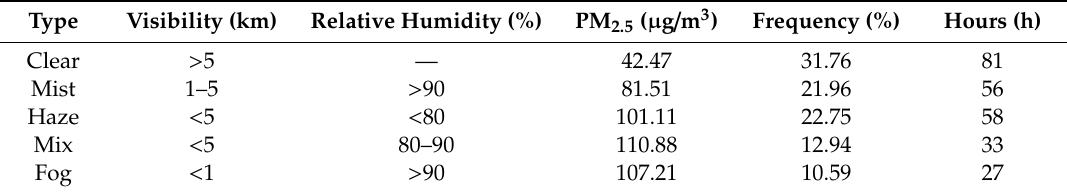
Table 1. The occurrence frequency of different processes in the haze-fog episode and the corresponding mean PM 2.5 mass concentration.